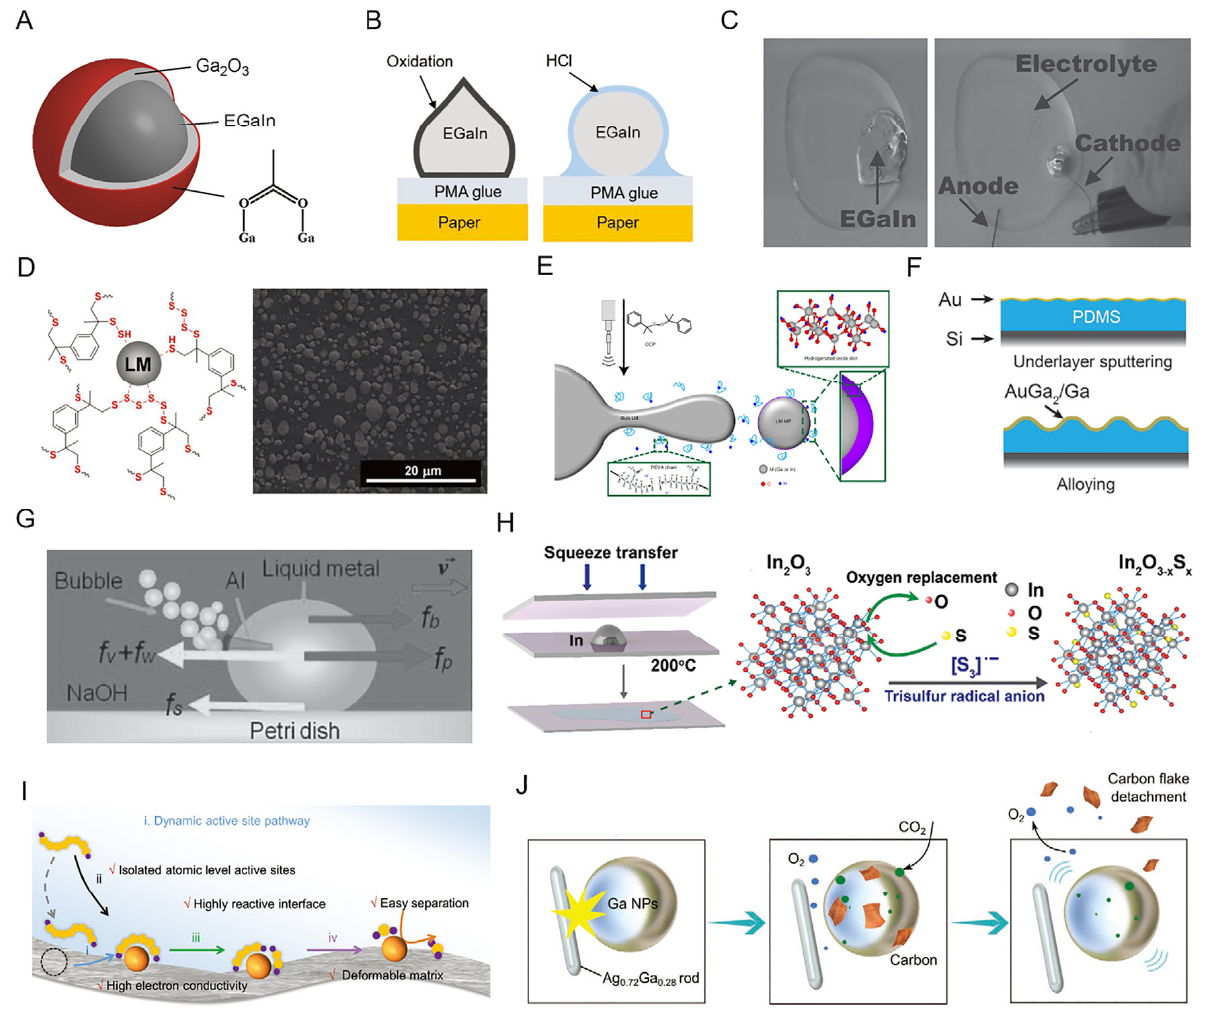
Figure 3. The fundamental chemical properties of LMs. ( A ) Illustration of the architecture of the oxidized liquid metal particle [42]. Copyright: (2014) American Chemical Society. ( B ) The schematic diagram of the liquid metal removed with HCL solution [45]. Copyright: (2018) WILEY-VCH. ( C ) Application of a reductive potential to the liquid metal removes the oxide [46]. Copyright: (2015) WILEY-VCH. ( D ) Scheme of the surface interactions between LM droplets with polysulfide loops (R-Sn-R) and thiol terminal groups (R-SH), and cross-sectional scanning electron microscope (SEM) image of the liquid-metal-embedded sulfur polymer [47]. Copyright: (2019) WILEY-VCH. ( E ) The process of hydrogen doping introduced by ultrasonication [48]. Copyright: (2021) Springer Nature. ( F ) Growth of biphasic gold–gallium thin films on a PDMS membrane [49]. Copyright: (2016) WILEY-VCH. ( G ) The Rehbinder effect between liquid metal alloy EGaIn or Galinstan and aluminum [50]. Copyright: (2015) WILEY-VCH. ( H ) Synthesis of 2D indium oxysulfide [53]. Copyright: (2021) The Royal Society of Chemistry. ( I ) Schematic illustration of the catalytic strategies using dynamic liquid metal electrocatalysts [51]. Copyright: (2022) WILEY-VCH. ( J ) Schematic illustration of the CO 2 conversion process. The formation/detachment of the carbon flakes and the generation/escape of O 2 are indicated [52]. Copyright: (2022) WILEY-VCH.